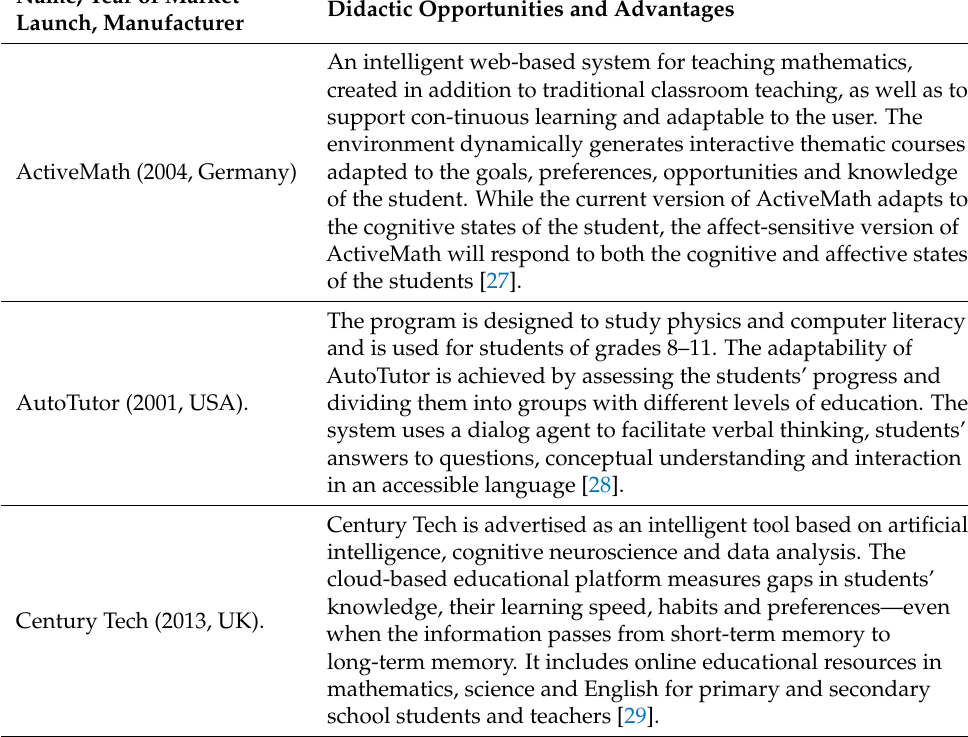
Table 1. Intelligent adaptive learning